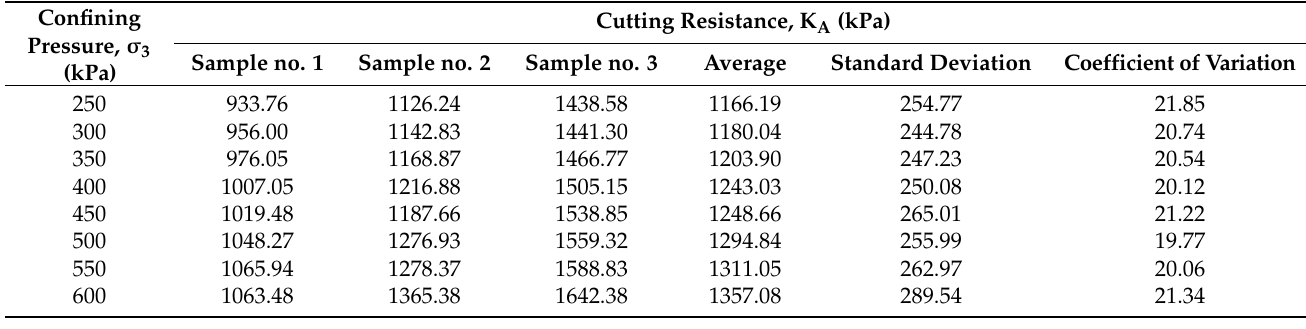
Table 2. Results of cutting resistance tests for all defined confining pressures, σ 3 .